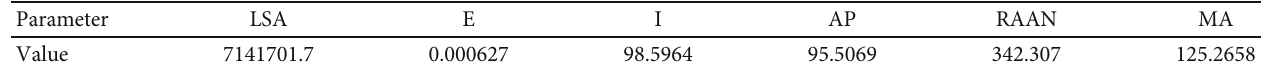
Table 3: Satellite orbital parameters.